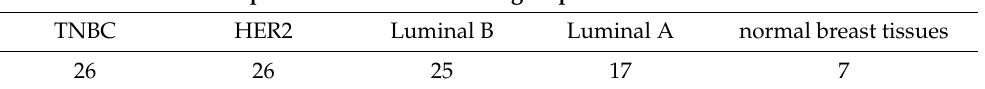
Table 5. Curie cohort (IHC): MEP50 expression (MEP50 staining, Figures 5 and 6) and PRMT5 activity (H4R3me2s staining, Figure 7) in breast cancer subgroups and normal breast tissues. Number of Samples in Breast Cancer Subgroups and in Normal Breast Tissues TNBC HER2 Luminal B Luminal A normal breast tissues 26 26 25 17